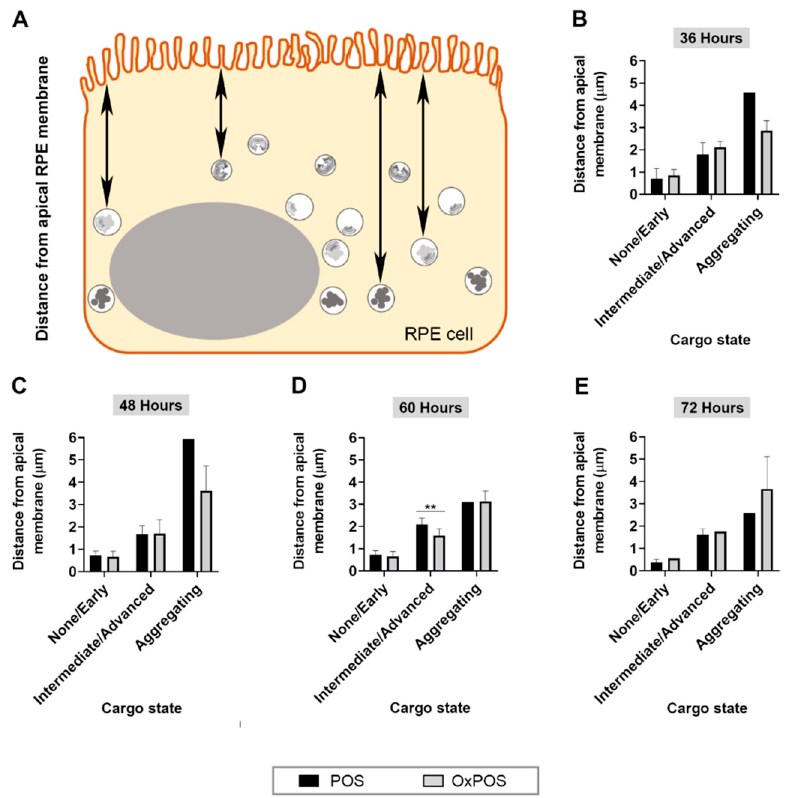
Figure 6. Timelines of POS and OxPOS tra ffi cking as a function of distance from the apical RPE surface. Vesicles containing POS or OxPOS were grouped according to the morphology of their contents: (1) no indication of breakdown or early degradation, (2) intermediate or advanced stages of breakdown or (3) displaying an aggregating phenotype. The distance from the apical RPE cell surface was then measured for each tra ffi cking vesicle. ( A ) Schematic diagram illustrating the method. Blinded electron micrographs were quantified for each group as a function of distance from the apical membrane and shown for the following time points: ( B ) 36 h, ( C ) 48 h, ( D ) 60 h and ( E ) 72 h. Histograms without any error bars indicate where a single vesicle containing presumably endogenous material or OxPOS cargos which were occasionally observed to be degraded were included in the analysis. POS breakdown and degradation of a limited proportion of OxPOS were correlated with increasing time and distance from the apical RPE surface. By contrast, aggregating OxPOS immediately localized to deeper layers of the cell from 36 h onwards. Data from a minimum of n = 10 fields / per time point. Statistical comparisons using a two-way ANOVA followed by Tukey’s multiple comparison test, where significant di ff erences between POS vs. OxPOS for each category is indicated as p ≤ 0.01